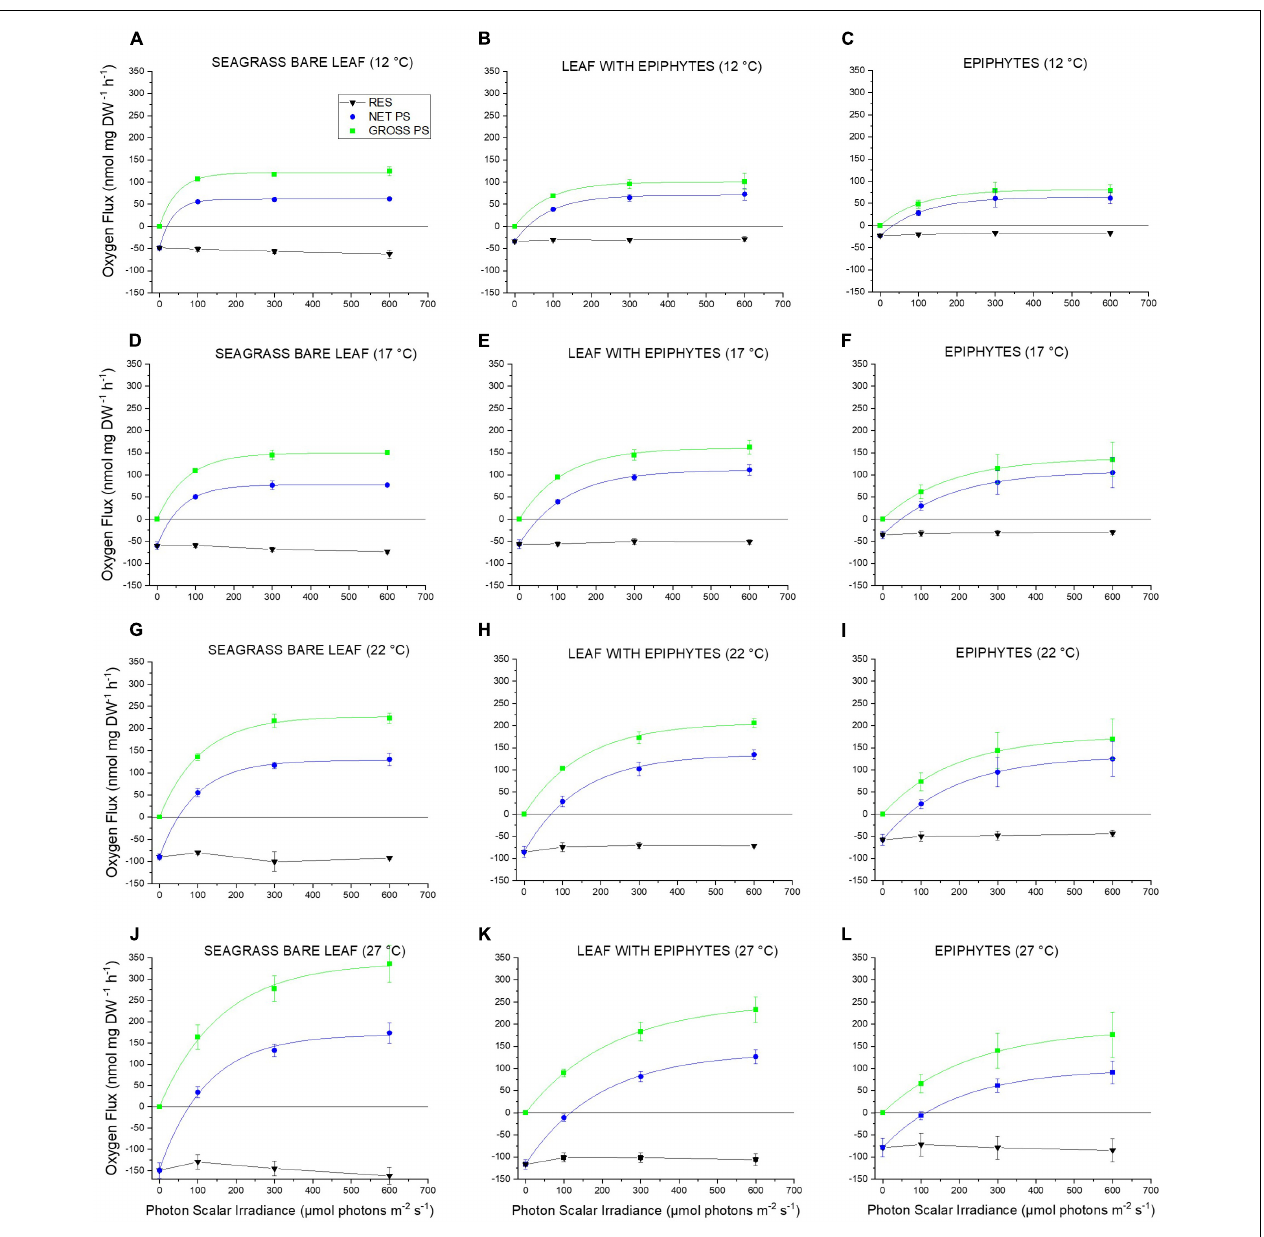
FIGURE 1 | (A–L) Respiration, net and gross O 2 production rates as a function of incident photon scalar irradiance for Z. marina L. leaves with and without epiphytes, as well as, for epiphytes originating from Z. marina L. leaves. The respiration, net and gross photosynthesis rates were measured for photon scalar irradiances (PAR, 400–700 nm) of 0, 100, 300, and 600 µ mol photons m − 2 s − 1 and temperatures of 12, 17, 22, and 27 ◦ C. Black symbols and lines shows respiration. Blue symbols and lines show net photosynthesis. Zero net O 2 production ( Y = 0) indicates the compensation photon irradiance of the seagrass leaves and epiphytes. Green symbols and lines show gross photosynthesis. Symbols with error bars represent mean values ± SEM; n = 4, biological replicates. All non-linear regression curve fits had an R 2 of ≥ 0.99. Detailed information about our statistical models can be found in Supplementary Notes 1 and Supplementary Tables 1–24 .